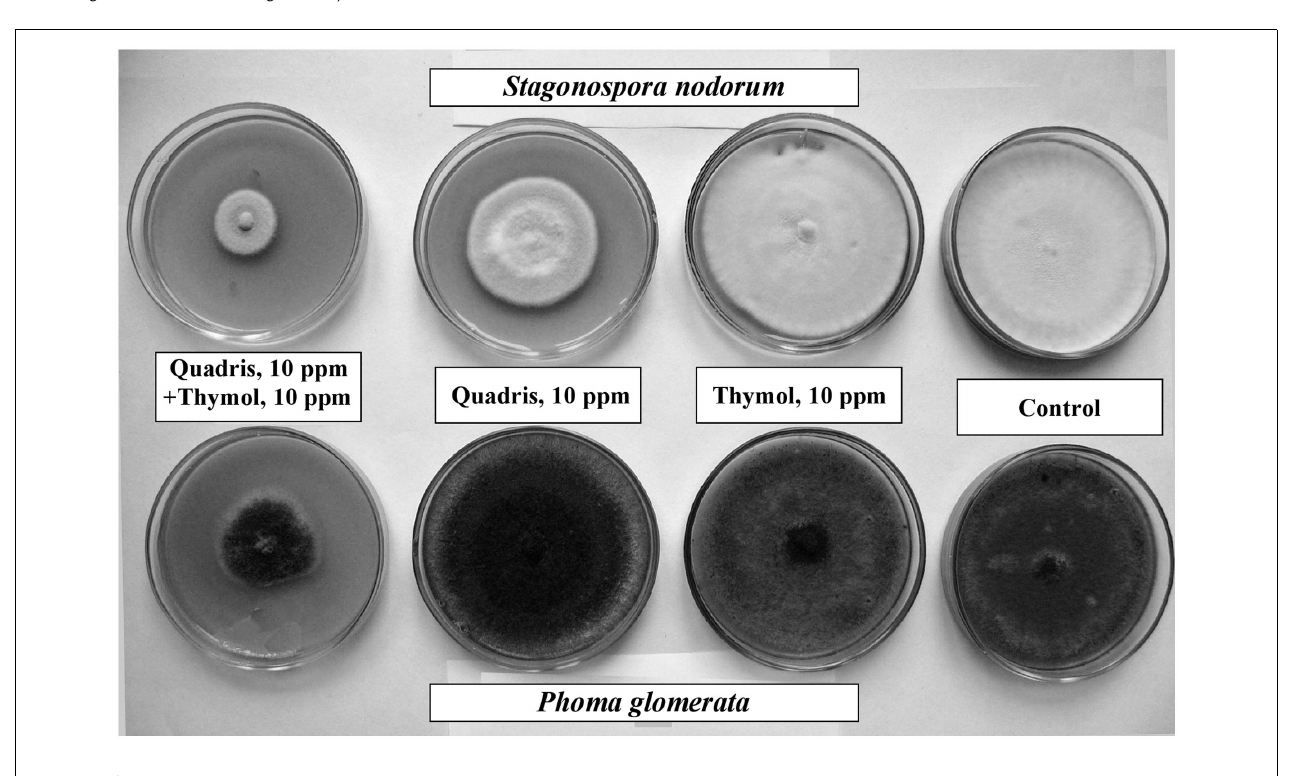
FIGURE 1 | Photographs of representative Petri dish cultures of S. nodorum and P. glomerata colonies grown in the presence of thymol alone (10ppm), Quadris alone (10ppm), or